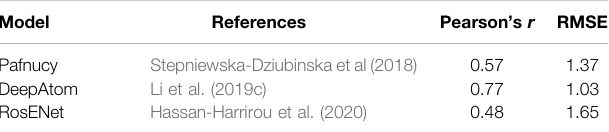
TABLE 4 | Performance of the models summarized in Table 2 on the Astex Diverse Set scoring benchmark. We only report evaluation results from the original reference. RMSEs are expressed in pK